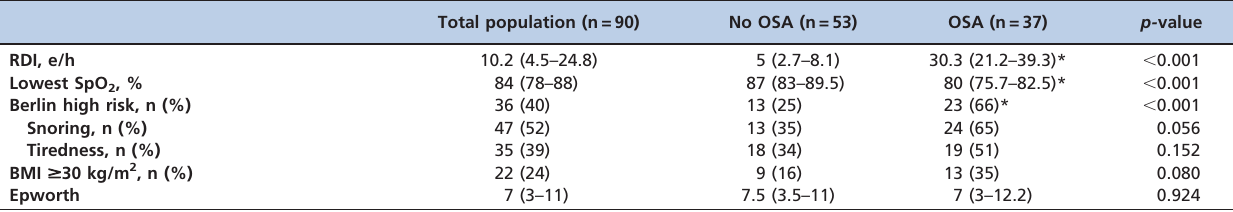
Table 2 - Respiratory parameters derived from portable monitoring and sleep questionnaires for the entire population and for patients with and without obstructive sleep